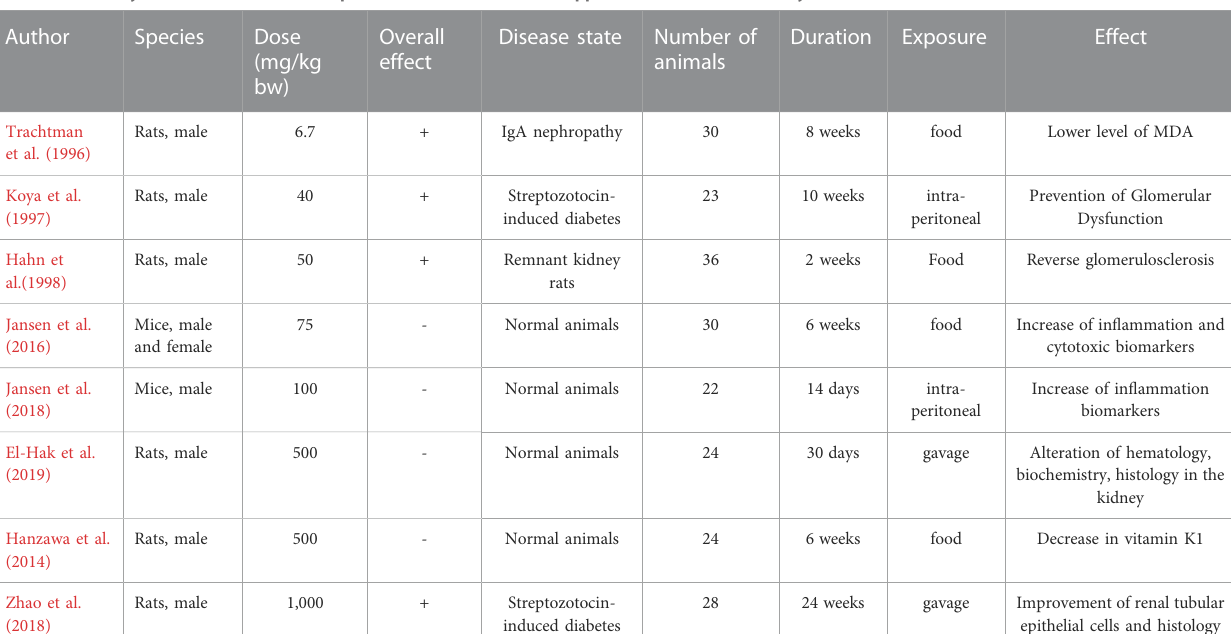
TABLE 4 Summary of rodent studies that reported effects of vitamin E supplementation on the